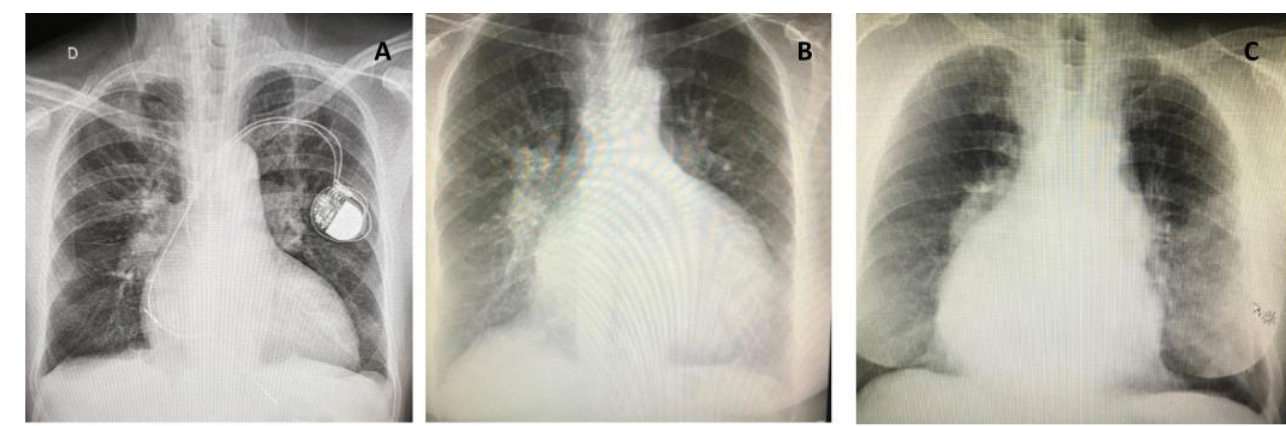
Fig. 4 - Chest radiographs of three patients with congenitally corrected transposition of the great arteries in heart failure. A) Deceased 70-year- old patient with tricuspid regurgitation (TR) + right ventricular (RV) dysfunction; B) 73-year-old patient with moderate TR/RV dysfunction (previous atrial septal defect closure) in NYHA class II; C) 69-year-old patient who refused surgery with large ventricular septal defect +